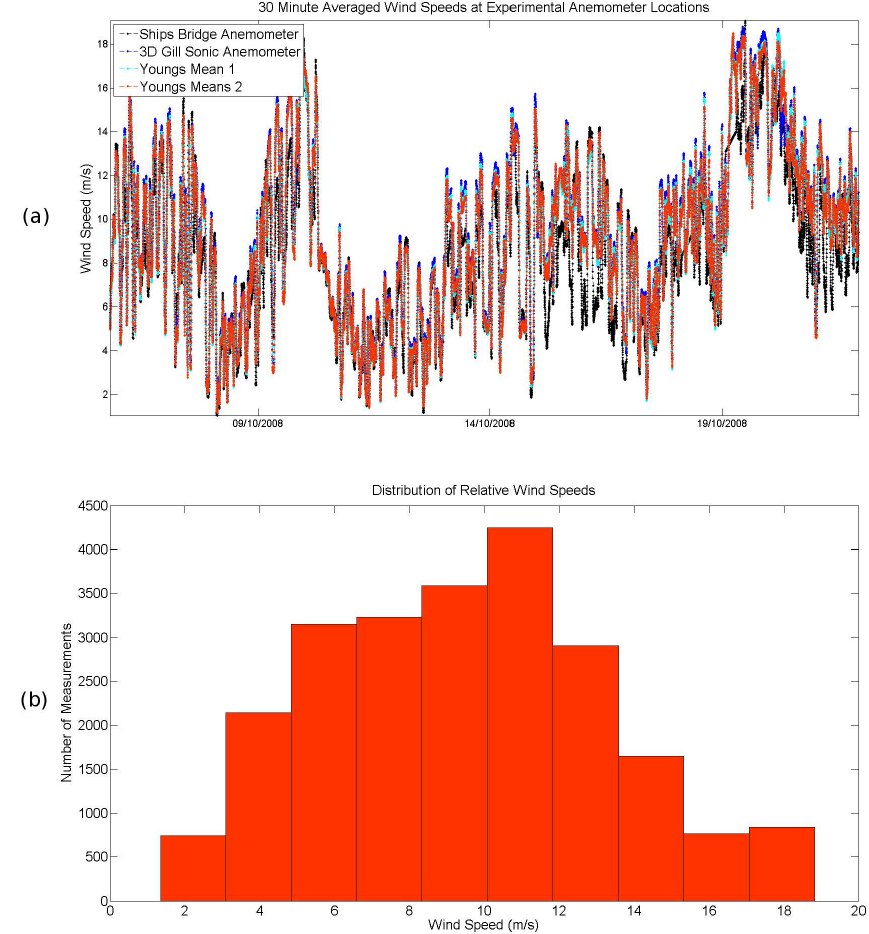
Fig. 4. (a) Thirty-minute-averaged true-wind-corrected measurements for the BMS, YM1, YM2 and SBD anemometers. (b) Histogram of distribution of measured wind speeds for chosen cruise period from the BMS